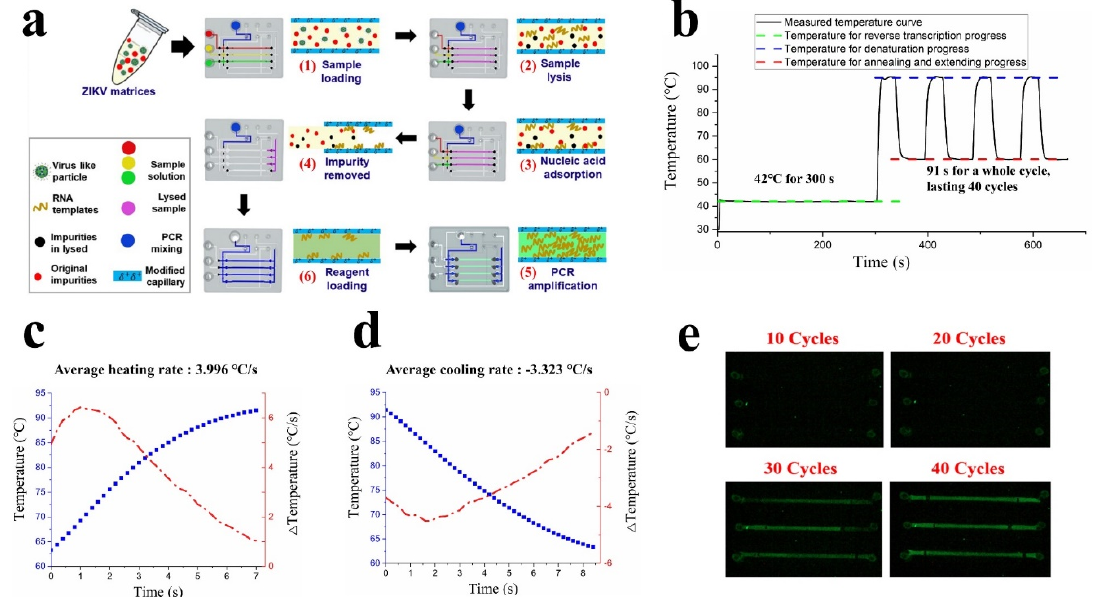
Figure 4. ( a ) Schematic diagram of the Zika virus (ZIKV) detection process on the microfluidic chip, including six steps: ( 1 ) Samples (RNA solution or ZIKV matrices mixing with lysate) loading into three capillaries. ( 2 ) Sample lysis in the capillaries. ( 3 ) Nucleic acids adsorption. After lysis process, the liquid remained in the capillaries for one minute, and target nucleic acids were expected to be adsorbed by capillaries. ( 4 ) Any impure liquid was removed from the port of the chip after RNA adsorption process. ( 5 ) RT-PCR reagent loading. ( 6 ) Executed RT-PCR process on the chip. ( b ) The curves of measured temperature during PCR process. The product was 42 °C for 5 min for reverse transcription, 95 °C for 15 s for denaturation, 60 °C for 40 s for primer annealing and extending, lasting 40 cycles. The time cost of an individual PCR cycle was around 91 s. ( c ) The figure of heating rate of the device. The blue curve represents the measured temperature during the heating process, and the red curve represents the heating rate. ( d ) The figure of the cooling rate of the device. ( e ) The images captured by the smartphone at different cycles during PCR amplification.